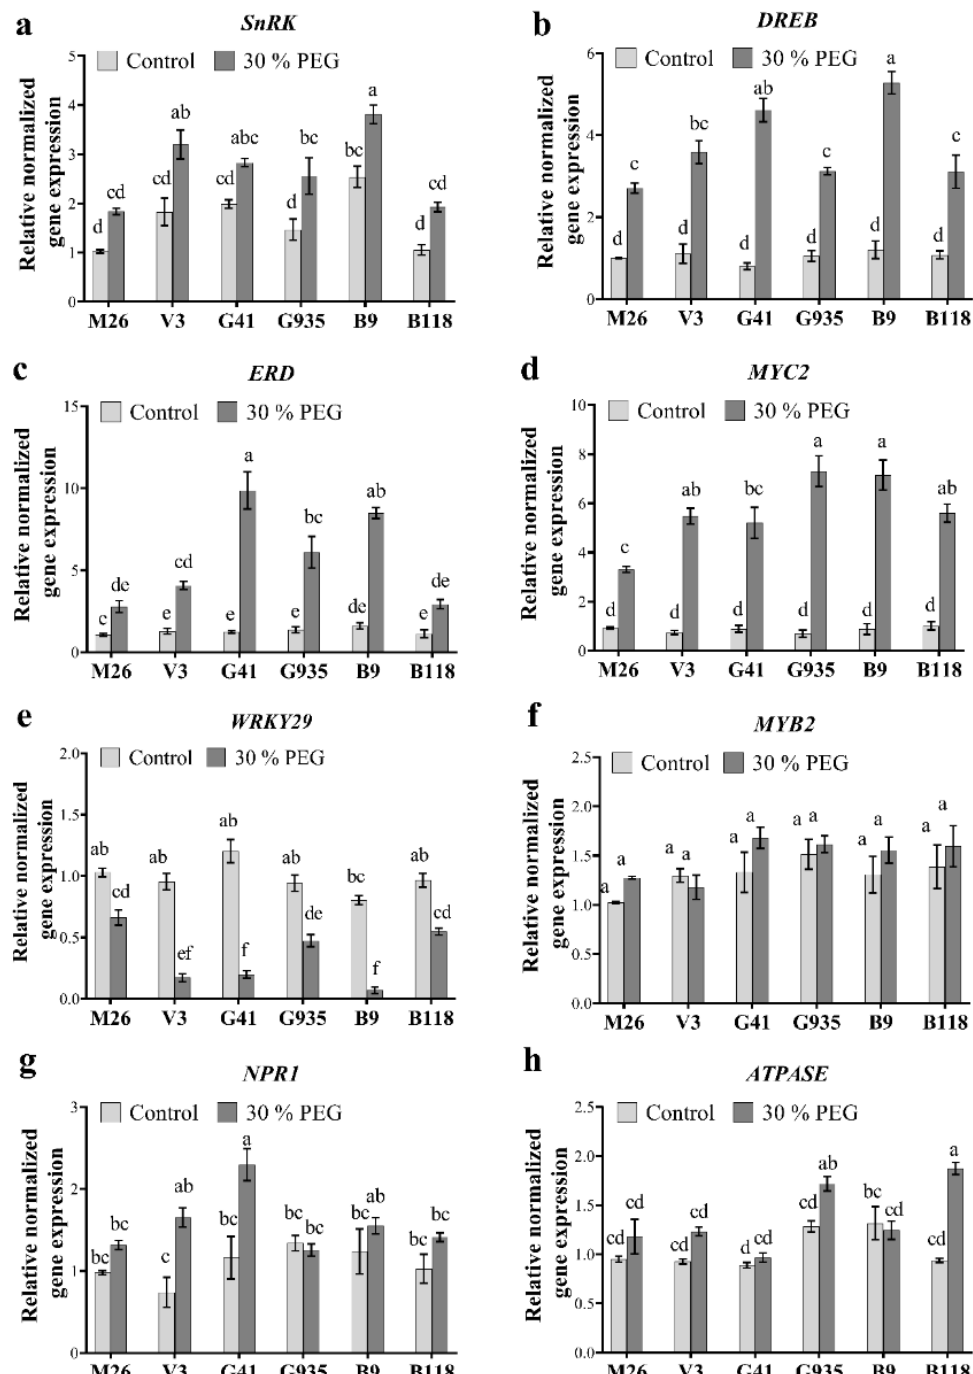
Figure 4. Expression profiles of eight ORGs ( a – h ) in six apple rootstocks (M26, V3, G41, G935, B9 and B118) exposed to 30% PEG treatment for 3 days. Genes differentially expressed in plants under stress conditions were normalized with MdEF1A. Means from all the treatments were compared with each other using Tukey’s test. Vertical bars represent the mean ± SEM of three biological replicates (three plants each). Bars with no common letters are significantly different ( p < 0.05).